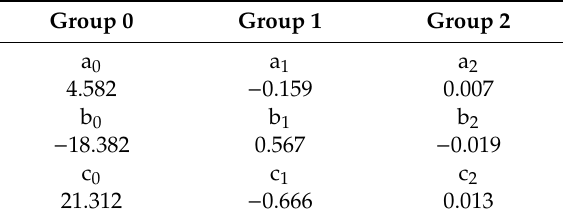
Table 2. Coe ffi cients of vapor pressure